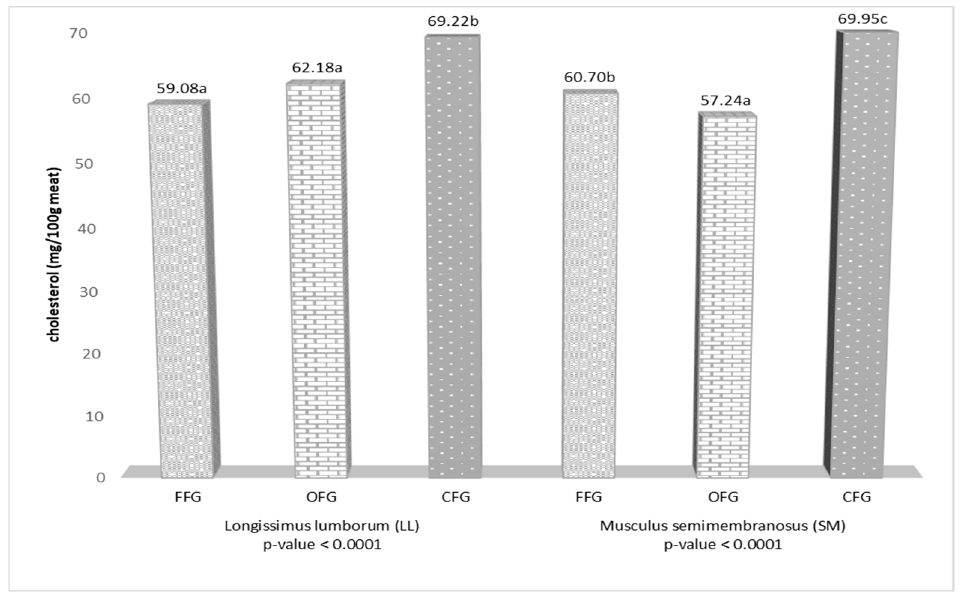
Figure 4. Content of cholesterol (mg/100 g meat) in the meat of red deer from the three feeding grounds (FFG—forest feeding ground; OFG—organic feeding ground; CFG—conventional feeding ground). For each muscle, means in the same row sharing different letters are significantly different.